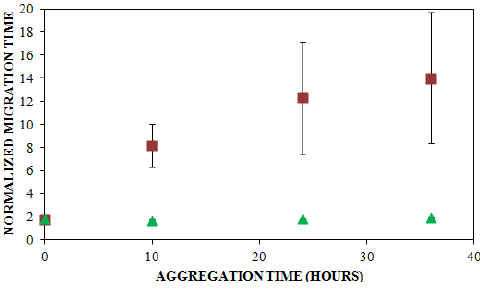
Figure 6. Coaggregation of FITC-labeled insulin and unlabeled insulin. Insulin solutions consisting of 25% FITC-labeled insulin and 75% unlabeled insulin with LIF detection (  , n = 6) and UV detection (  , n = 3) were prepared at a concentration of 0.2 mg/mL in 40 mM Tris (pH 8.0) containing 150 mM NaCl. Solutions were subjected to agitation (185 rpm), and the formation of aggregates was monitored. LIF-CE was performed with a sample injection at 12 kV for 12 s with 15 kV separation and UV-CE was performed with a sample injection at 10 kV for 12 s with 15 kV separation. Both separations were performed using 1% PHEA separation matrix in PHEA coated capillary. Migration times were normalized as described in Figure 2. Error bars represent SE, n = 3–6. Some error bars lie within symbols. For all time points >0 h, UV data was statistically different from the LIF data with a p <